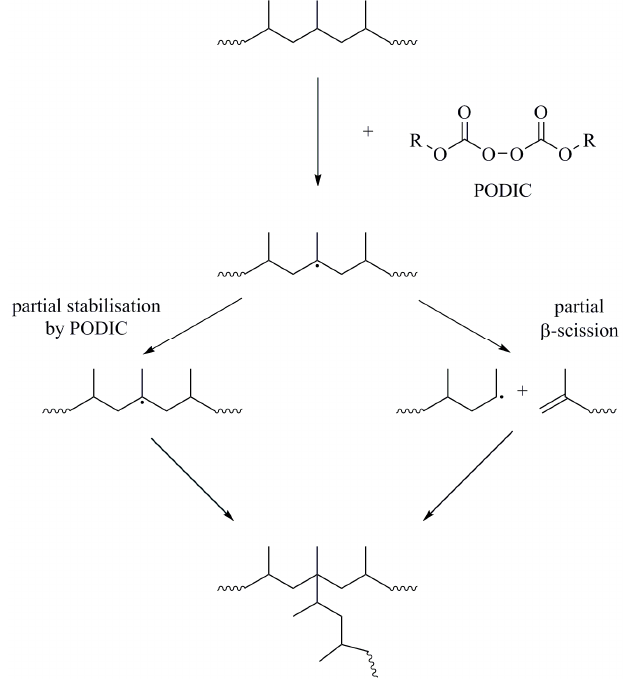
Figure 1. Reaction scheme of LCB process assisted by PODIC, according to Lagendijk et al.